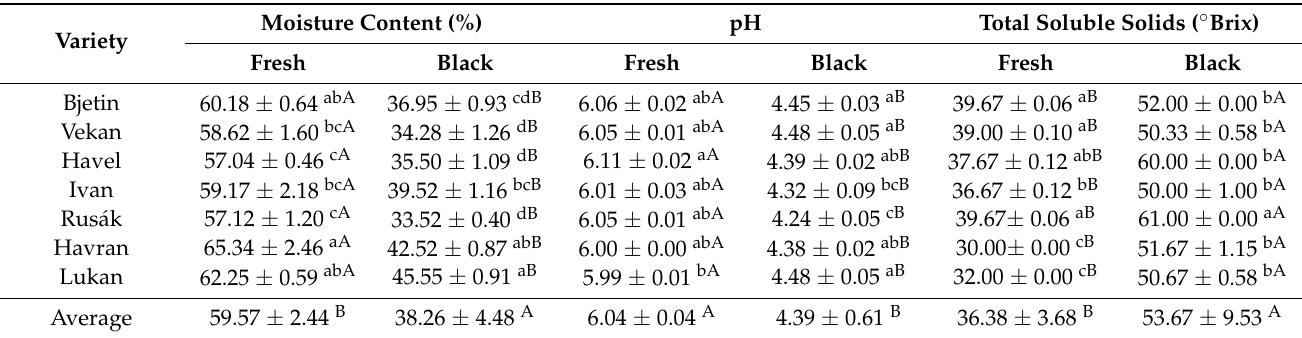
Table 1. Moisture content, pH, and total soluble solids of fresh and black garlic